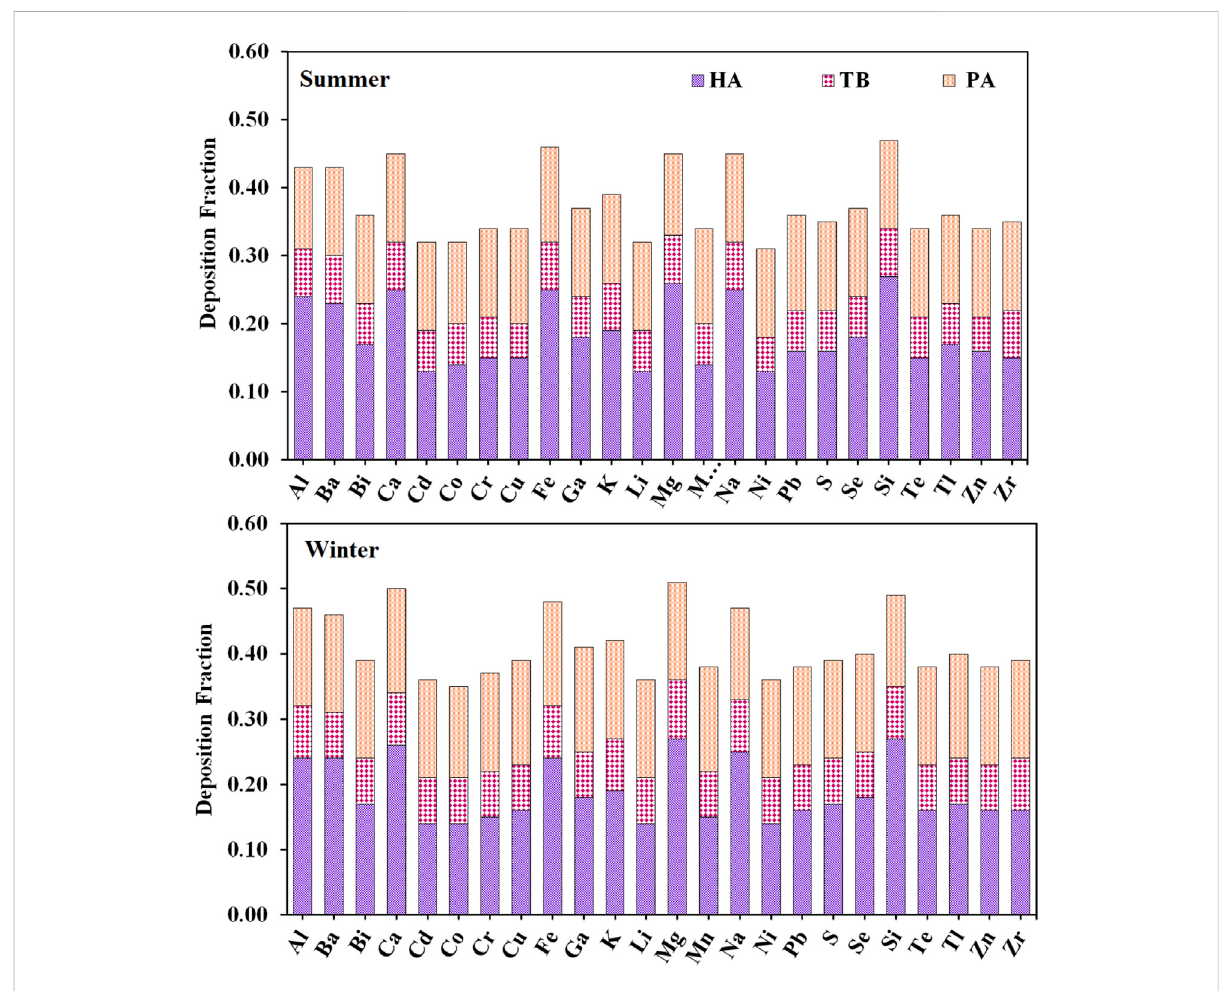
FIGURE 8 Deposition fraction ofelements in various regions ofthe human respiratory tract(HA: head airway, TB: trachea and bronchiolar, PA: pulmonary and alveolar) during summer and